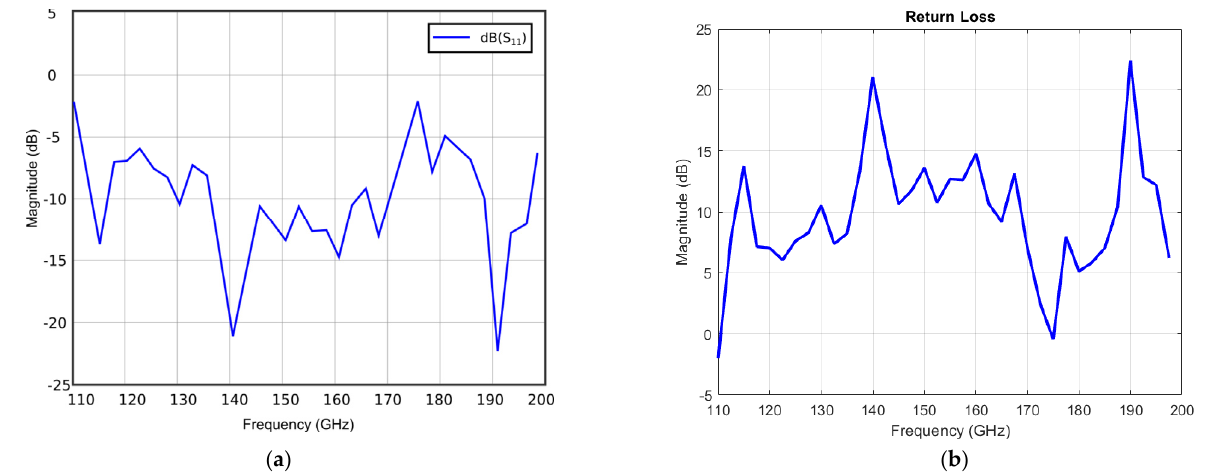
Figure 17. Minkowski fractal antenna for 3 iterations: ( a ) Self-reflection coefficient S 11 , ( b ) Return loss.